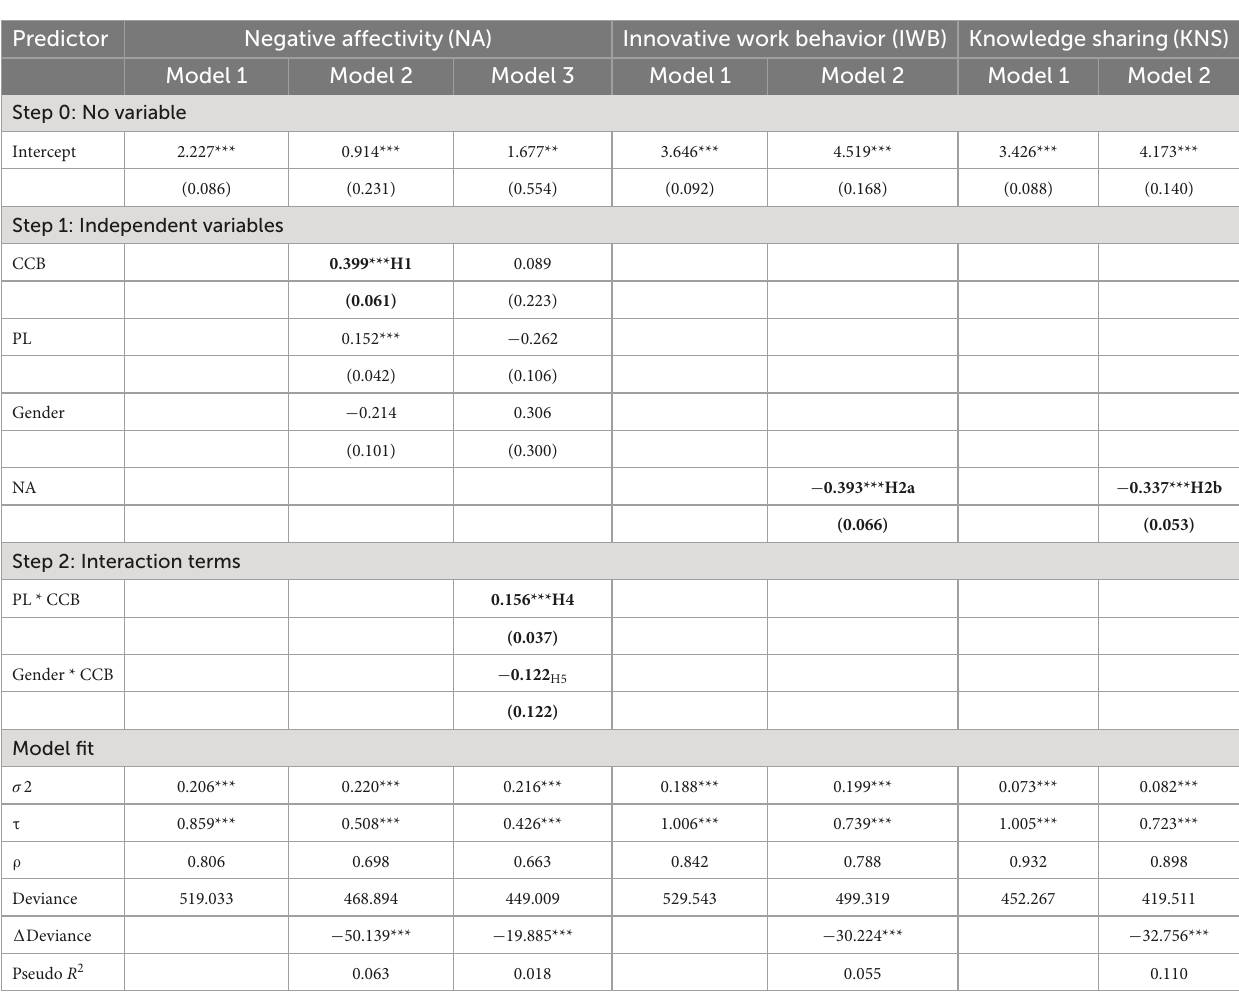
TABLE 3 Results of causal and moderation analysis using